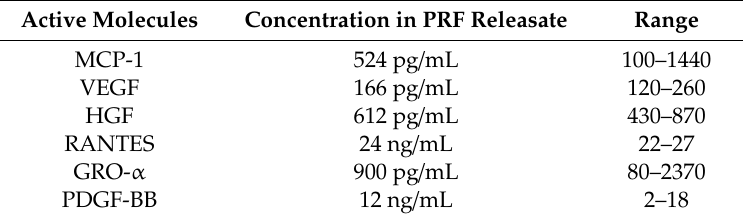
Table 2. The concentration of relevant molecules involved in healing mechanisms in platelet-rich fibrin PRF